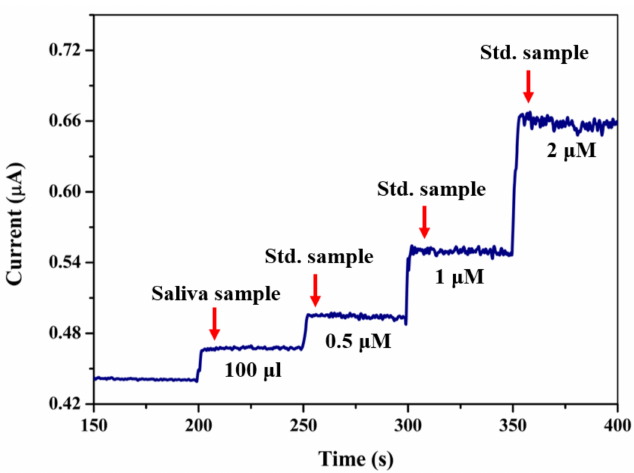
Figure 15. Amperograms were recorded using an Ag-NPs/GCE for NIC analysis in ( a ) Tobacco, and ( b ) saliva samples, after the additions of different volume of samples in to 0.1 M PBS. The applied potential was 1 V and a rotation speed was 750 rpm.